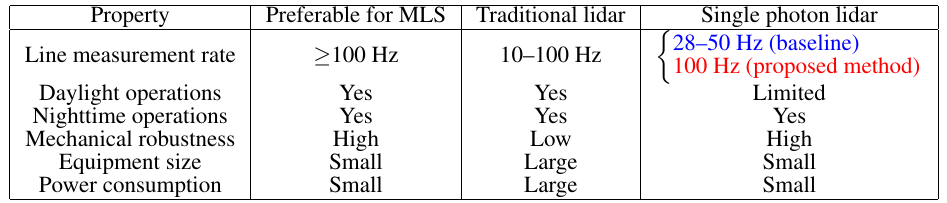
Table 1. Strengths and weaknesses of single photon lidar in mobile laser scanning. Preferences follow from authors’